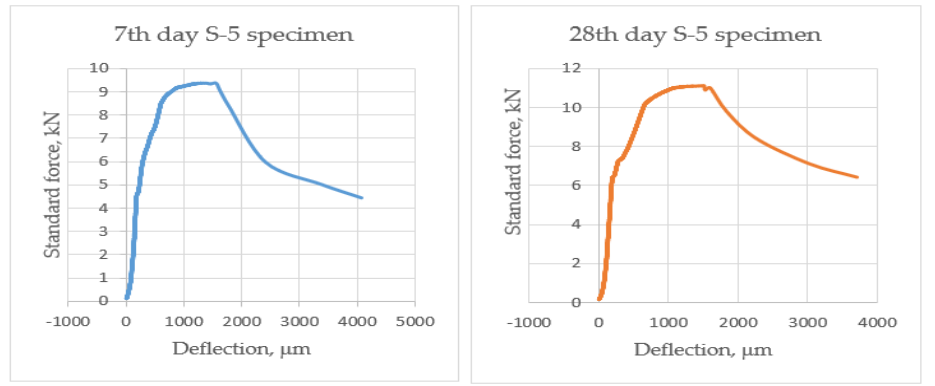
Figure 12. Crack behavior of sample S-5 after 7 and 28 days of hardening.